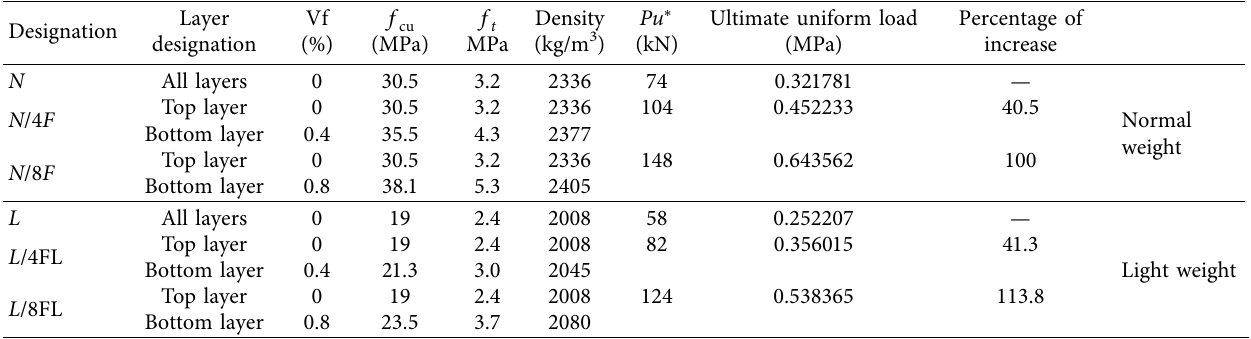
Table 10: Effect of steel fiber content ( V f )% on ultimate uniform load for -normal and lightweight concrete slabs.